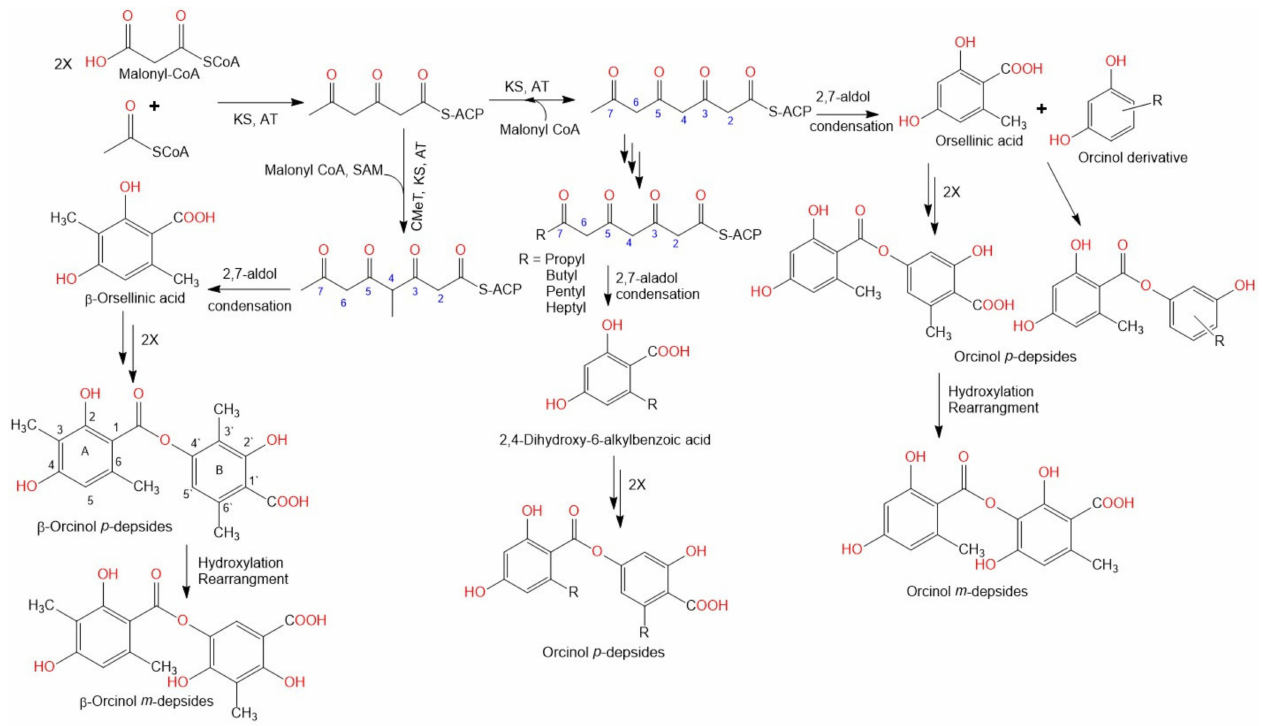
Figure 2. Biosynthesis of depsides